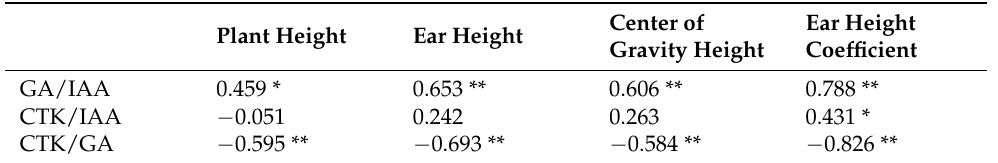
Table 5. Pearson’s correlation coefficients and their statistical significance of endogenous hormones ratio and plant agronomic traits.